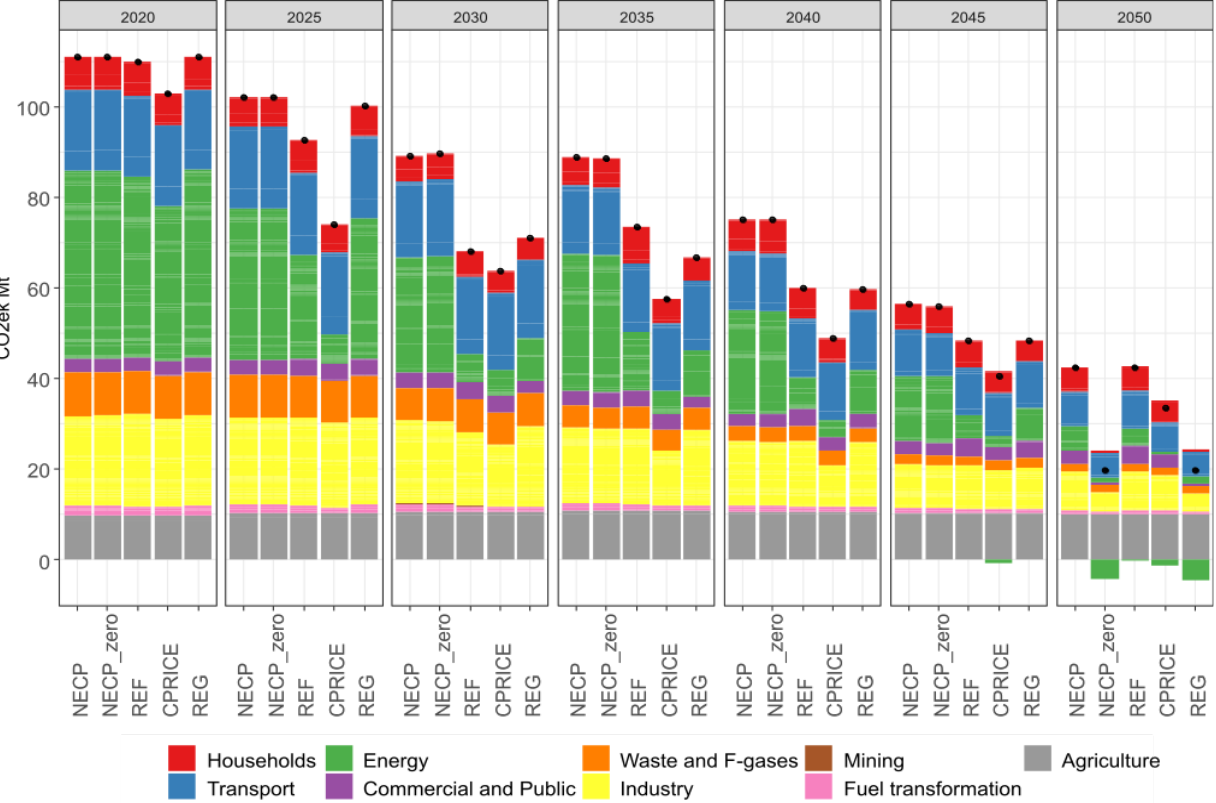
Figure 7. Emissions of GHG by sector (without LULUCF).